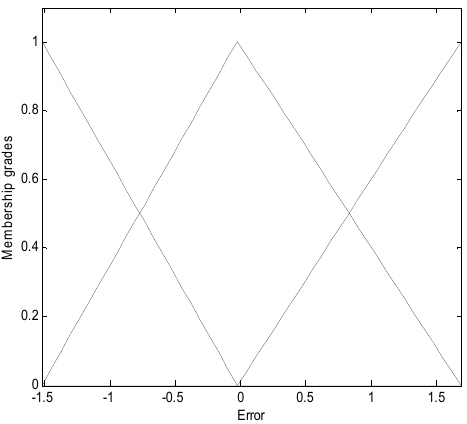
Figure 5. Linguistic contexts produced by the error distribution for treadmill data (p = 3).